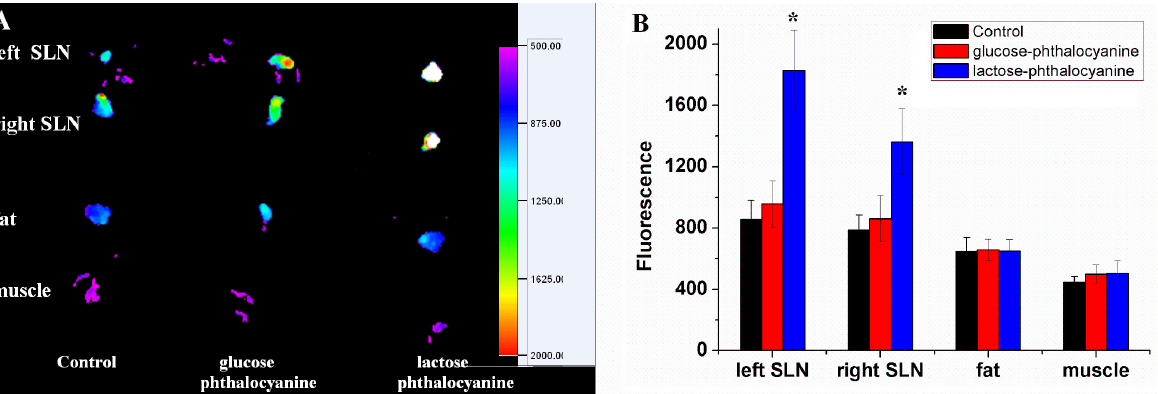
Figure 8. Distribution and fluorescence intensity of dissected organs. ( A ) Ex vivo imaging with an exposure time of 20 s (filters: excitation 625 nm, emission 700 nm); ( B ) Quantitative analysis of fluorescence intensity ( p < 0.05, compared to control group, n =